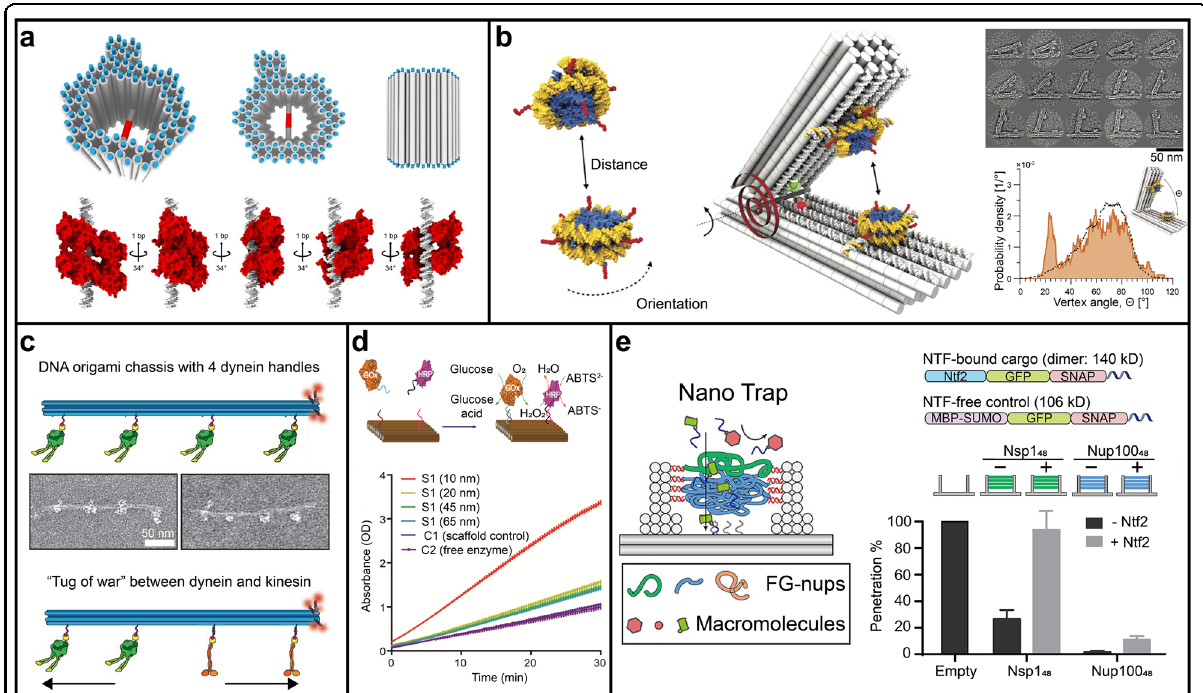
Fig. 3 Manipulating biomolecules with DNA origami scaffolds. a A DNA origami support with a docking site for the DNA-binding P53 protein for cryo-EM structure analysis. The relative angle of the P53 protein is controlled by rotating the docking site in the DNA origami object, and the P53 protein is protected in the hollow support structure from the detrimental effects of sample preparation. (Reproduced with permission 73 , Copyright 2016, Proceedings of the National Academy of Sciences). b A DNA origami clip consists of two beams and a torsional spring for determining the interaction between two nucleosomes. The distance and relative orientation of two nucleosomes can be adjusted, and the interaction between two nucleosomes will shift the angle distribution of the clips, which re fl ects the energy landscape of nucleosome-nucleosome stacking. (Reproduced with permission 94 , Copyright 2016, AAAS). c A DNA origami rod for exploring the mechanisms of the coordinate motor ensemble. Dynein and kinesin can be immobilized on the DNA origami rod in different combinations, and the fl uorescent signal is used to characterize the walking of the complex structure on the microtubule track. (Reproduced with permission 103 , Copyright 2012, AAAS). d The GOx/HRP enzyme pair arranged at different distances on a DNA origami plate for interenzyme substrate diffusion investigation. (Reproduced with permission 114 , Copyright 2012, American Chemical Society). e A DNA origami-protein hybrid Nano Trap for studying the selective fi ltering properties of intrinsically disordered Phe-Gly-rich nucleoporins. (Reproduced with permission 130 , Copyright 2021, American Chemical